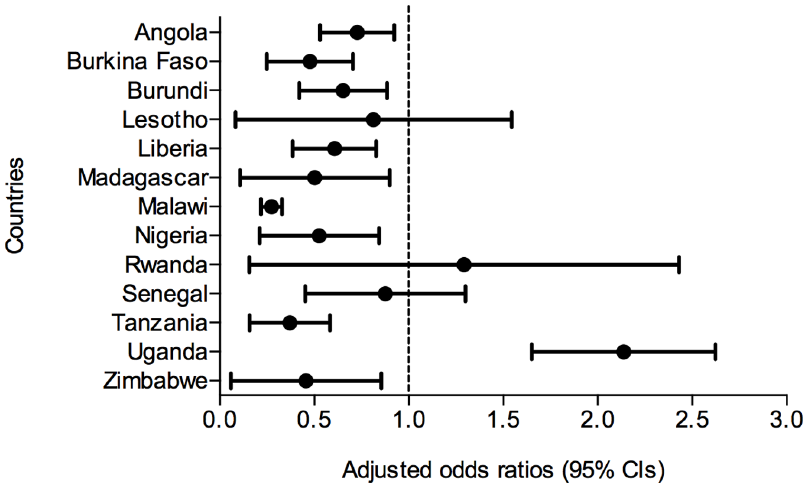
Figure 2. Forest plot of test uptake at non-hospital sources versus hospitals in each country. Figure legend: CI refers to confidence interval. Mixed-effects logistic regression models adjusted for data clustering and Table 3 covariates. AOR , 1.0 indicates reduced odds of testing at